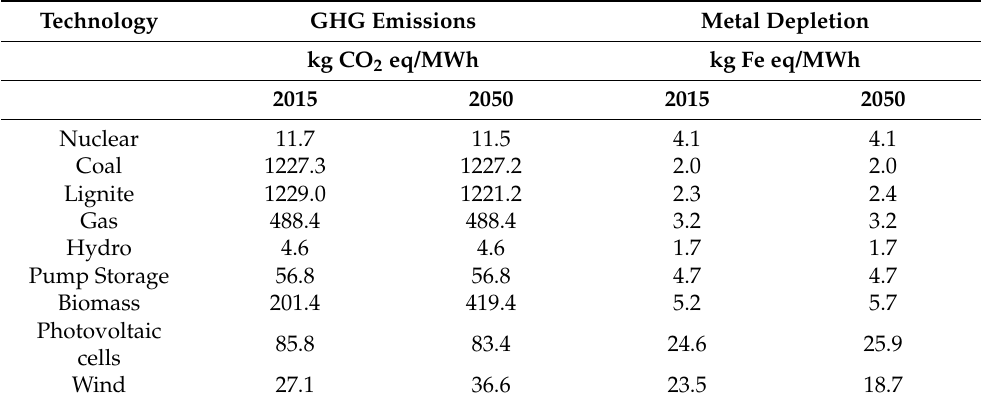
Table A1. GHG emissions and metals depletion by technologies, 2015 and 2050.